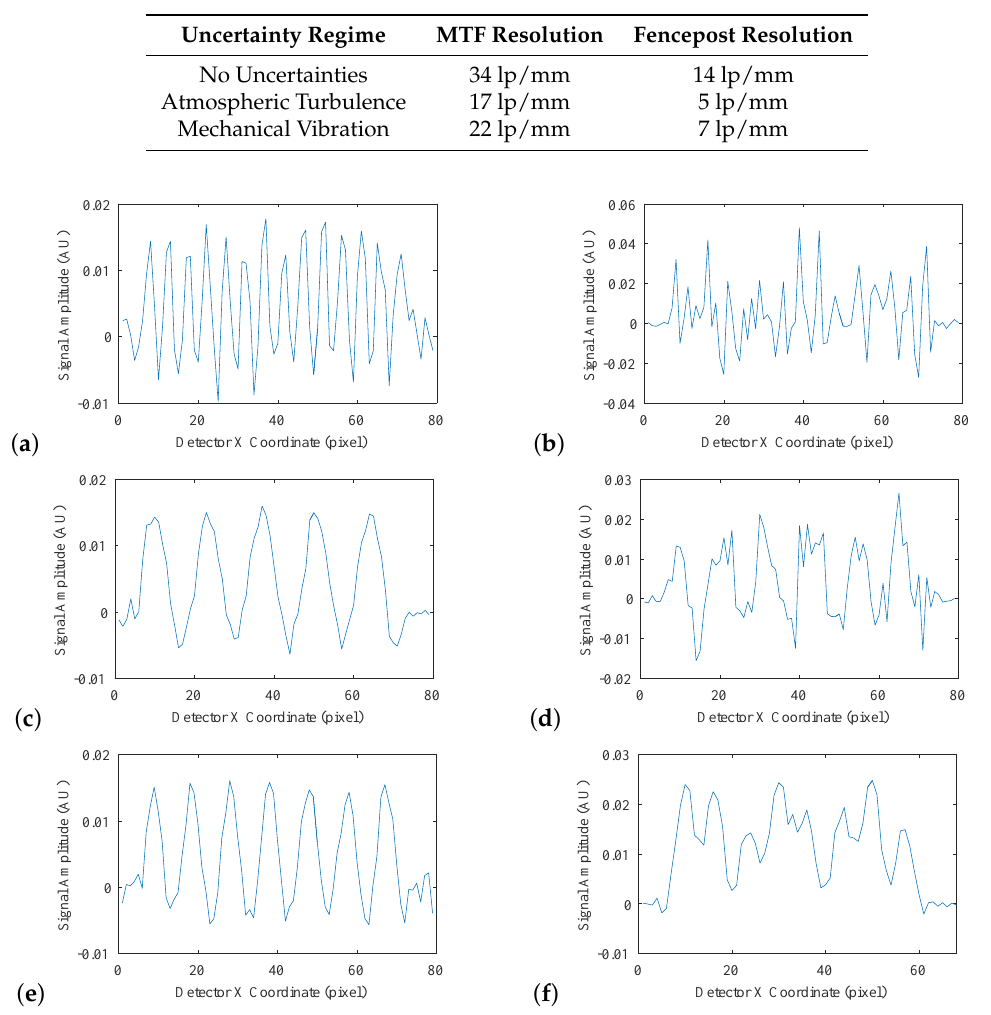
Figure 11. Intensity profiles across different regions of the reconstructed fencepost phantom. ( a ) Collected 14 lp/mm region with no simulated uncertainties; ( b ) collected 15 lp/mm region with no simulated uncertainties; ( c ) collected 5 lp/mm region with simulated atmospheric turbulence; ( d ) collected 6 lp/mm fencepost region with simulated atmospheric turbulence; ( e ) collected 7 lp/mm region with simulated mechanical vibration; ( f ) collected 8 lp/mm fencepost region with simulated mechanical